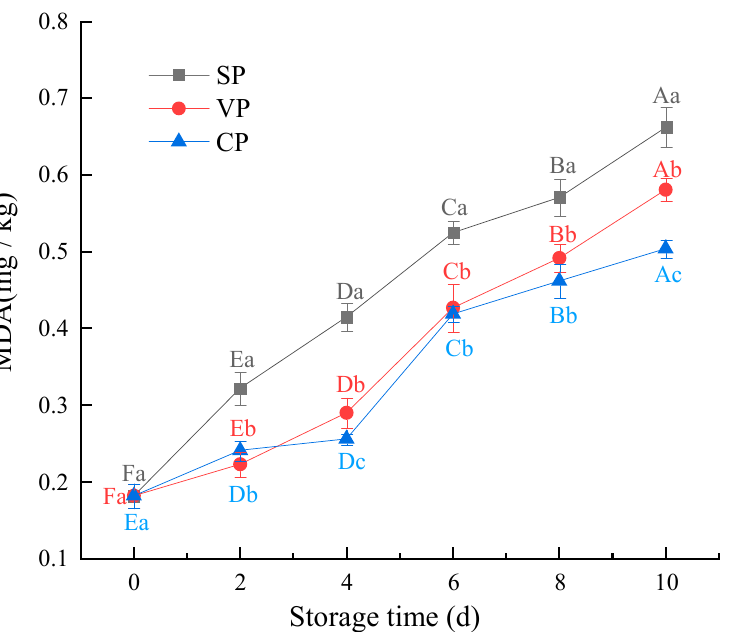
Figure 5. Changes in the MDA content of pike eels over 10 days of chilled storage. SP, simple packaging; VP, vacuum packing; and CP, stable chlorine dioxide pretreatment combined with vacuum packing. Different uppercase letters indicate significant differences in the MDA content of pike eels during 10 days of chilled storage ( p < 0.05). Different lowercase letters indicate significant differences in the MDA content of pike eels for the same storage time ( p < 0.05).